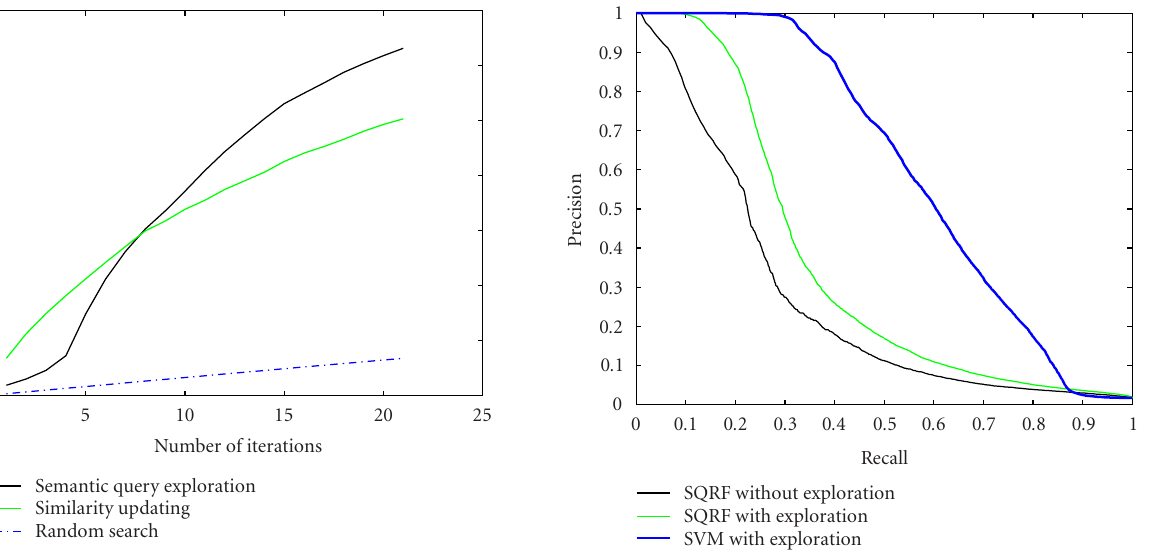
Figure 14: Precision/recall curves for semantic query relevance feedback and SVM methods with or without exploration strategy (cavern